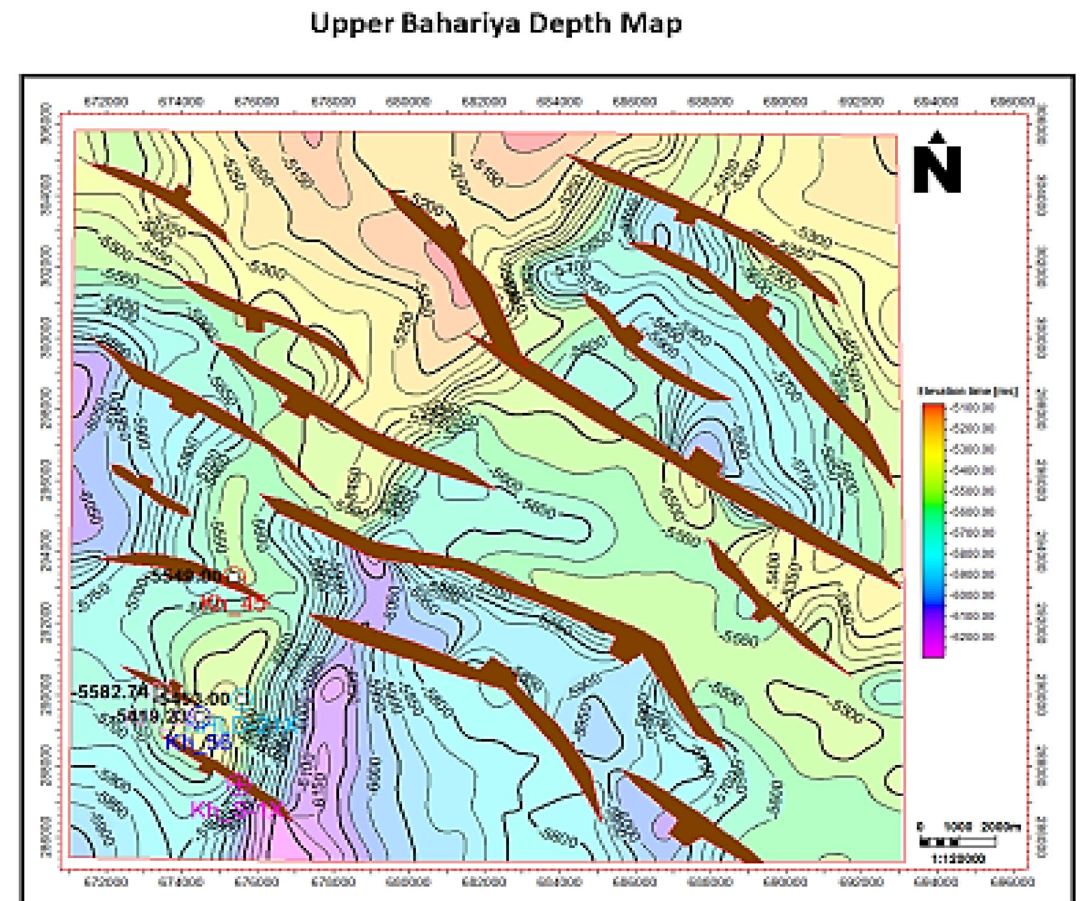
Fig. 15 Depth structure contour map on the top Upper Bahariya Formation in the study Area (C.I = 100